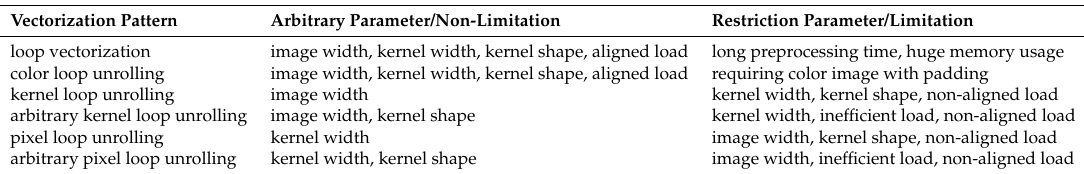
Table 1. Characteristics of the vectorization patterns of vectorization in finite impulse response image